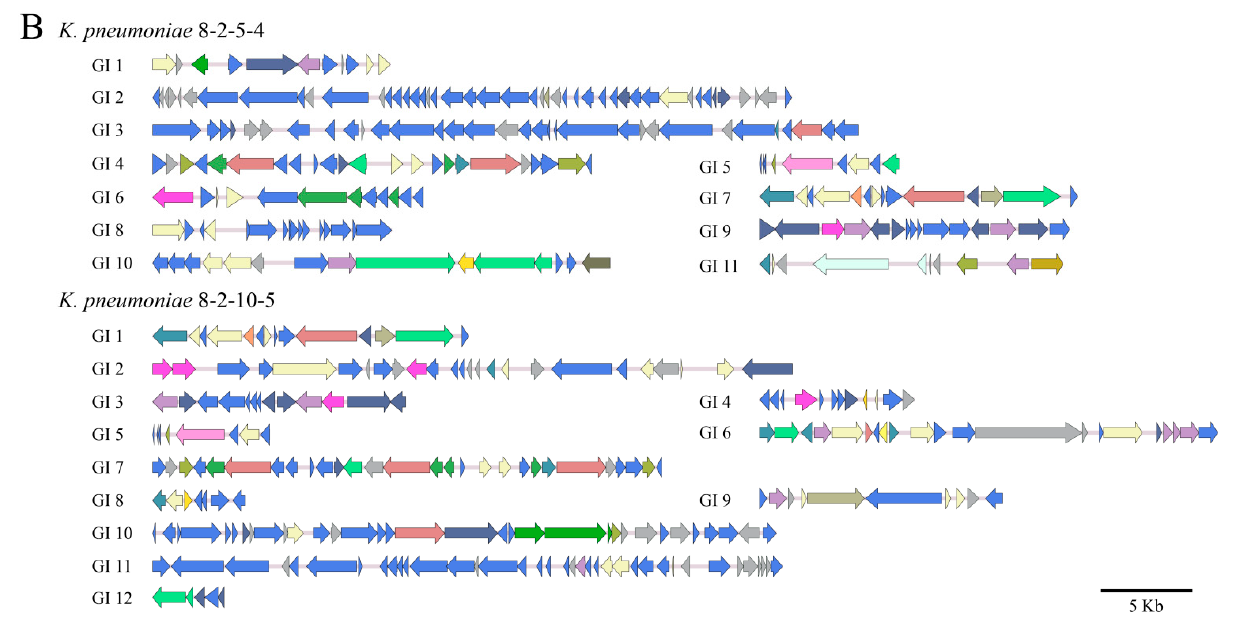
Figure 3. Gene organizations of the GIs identified in the K. pneumoniae genomes ( A , B ). Different colors referred to COG classification to mark gene functions, and genes not annotated to COG database were displayed in grey.